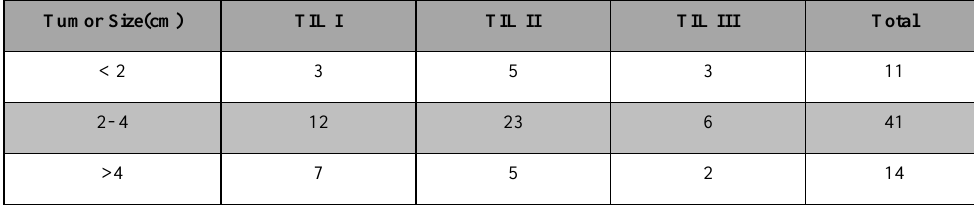
Table 3. TIL Score correlation with tumor size.